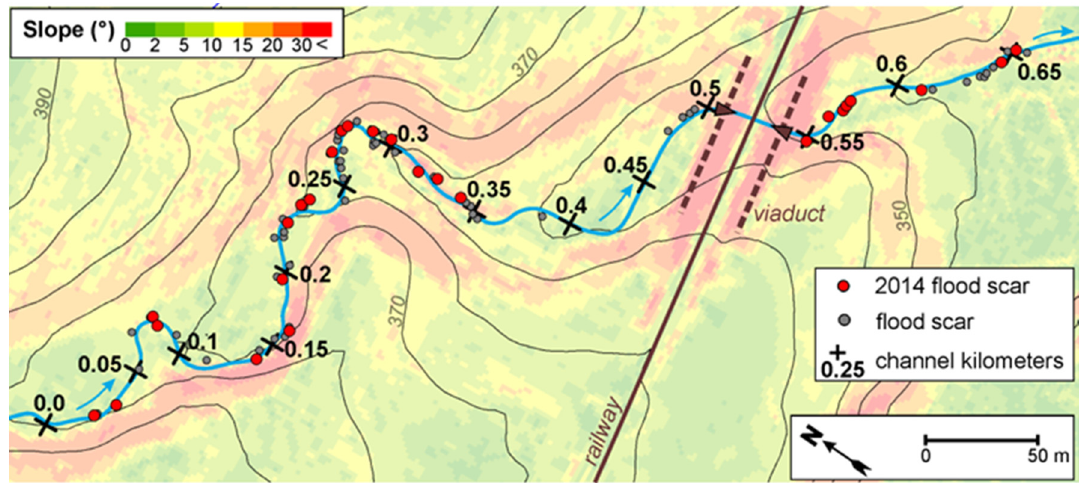
Figure 5. Localization of the 2014 flood scars within the studied channel reach.